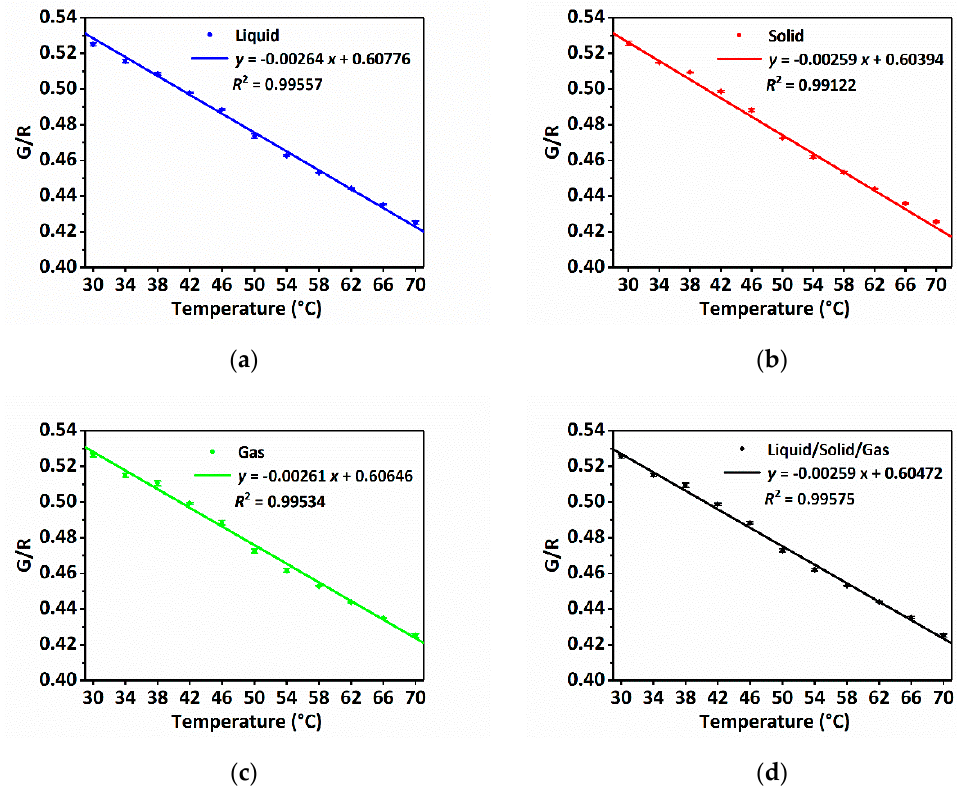
Figure 5. Sensor calibration. ( a ) Measured and fitted G/R-temperature relation in the liquid sensing condition; ( b ) measured and fitted G/R-temperature relation in the solid sensing condition; ( c ) measured and fitted G/R-temperature relation in the gas sensing condition; ( d ) the unified G/R-temperature relation for all environmental conditions.